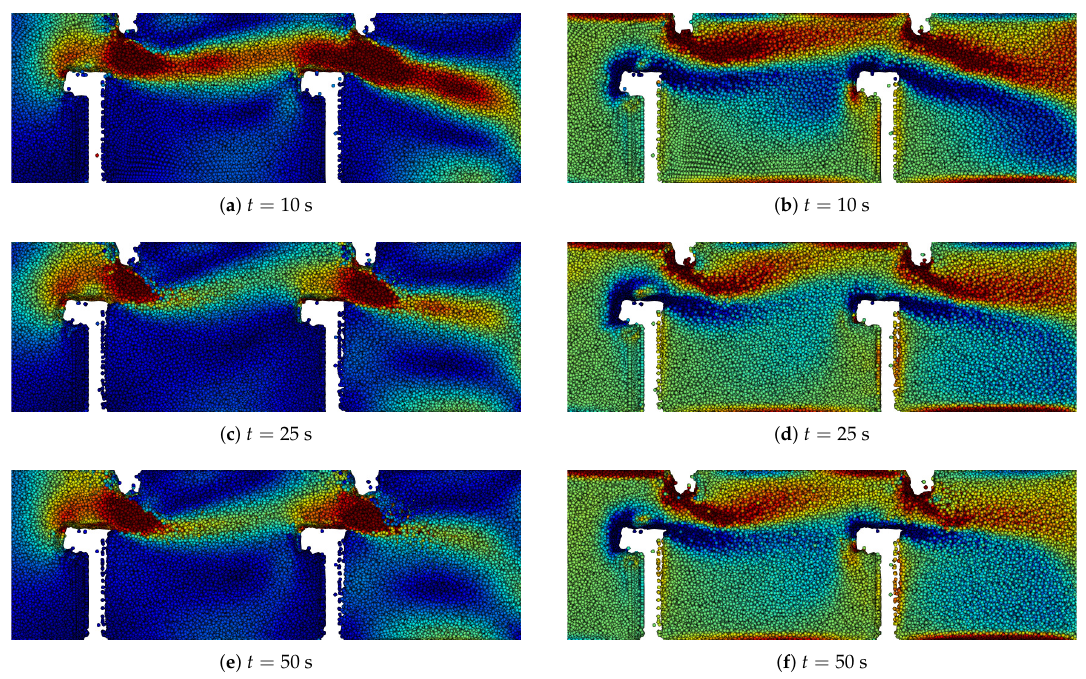
Figure 3. Contour maps of flow variables at the free surface (top view). Left panels represent velocity magnitude, colored from 0 m/s (blue) to 1.5 m/s (red). Right panels show contours of vorticity in z , from –3 rad/s (blue) to 3 rad/s (red).